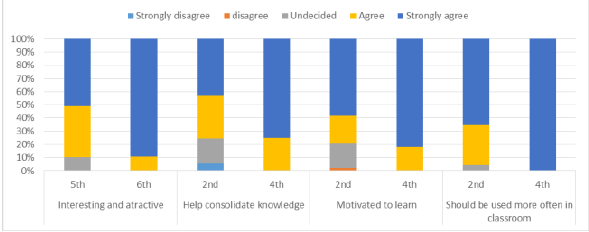
Figure 9: Second cycle students’ perceptions about learning